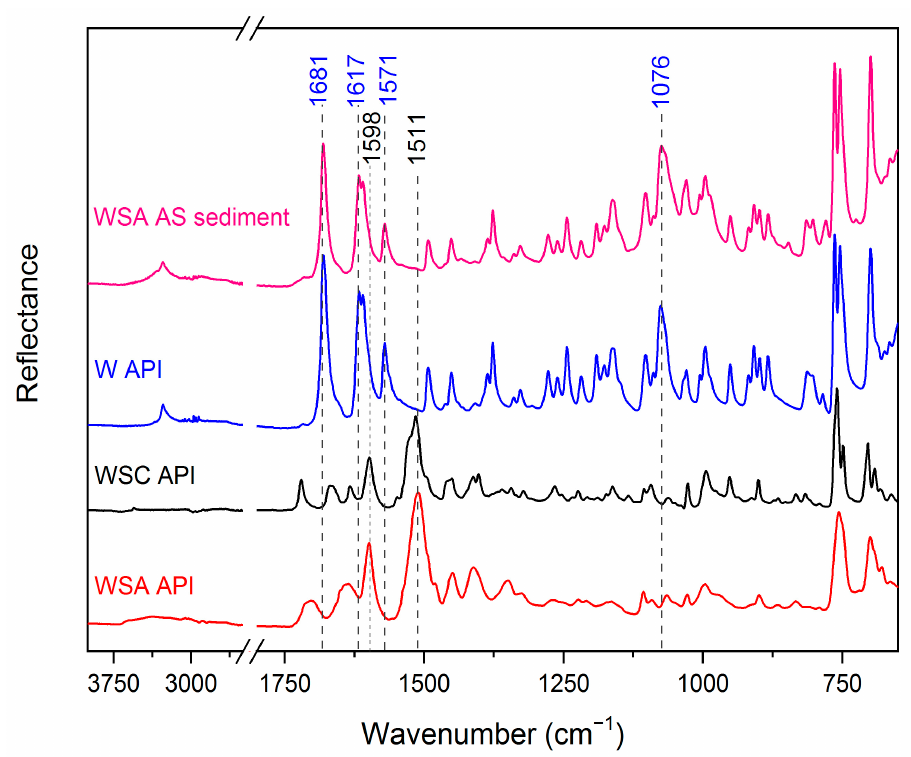
Figure 5. ATR spectra of the sediment obtained from the aqueous solution of warfarin sodium amorphous (WSA AS), warfarin (W) API, warfarin sodium clathrate (WSC) API, and warfarin sodium amorphous API.